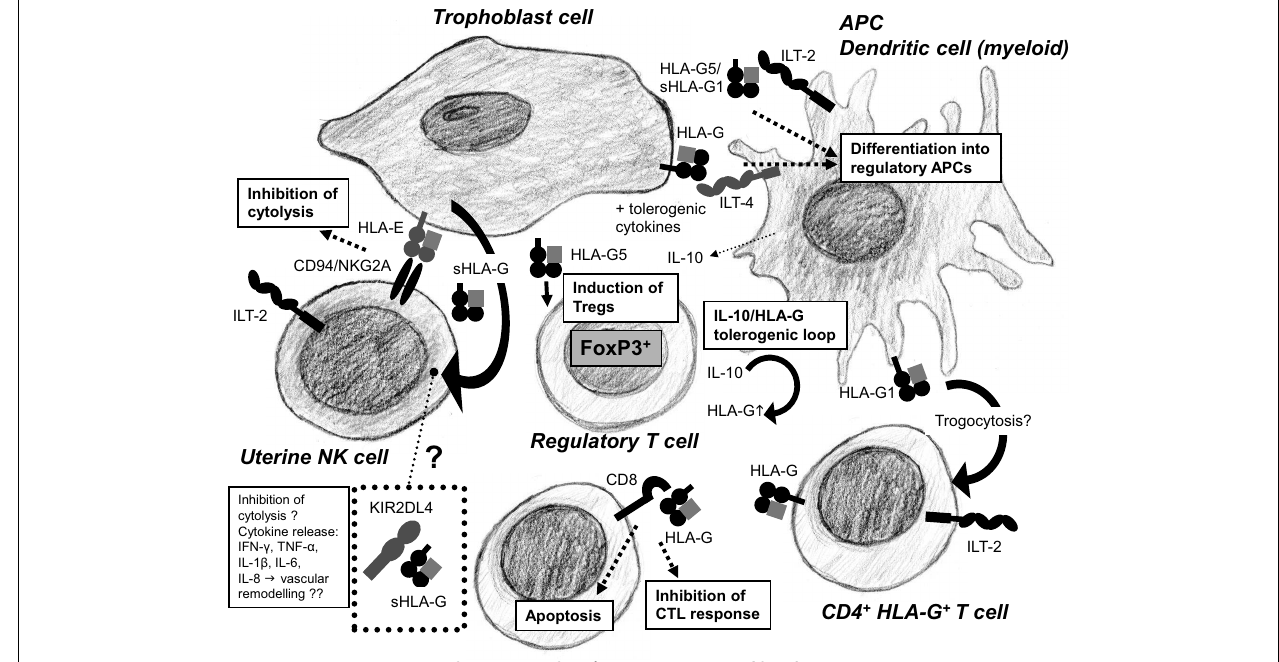
CD8 + T cells are inactivated and undergo apoptosis by binding of HLA-G to the CD8 co-receptor. HLA-E presents HLA-G derived signal peptides and bind to the CD94/NKG2A receptors on uterine NK cells inhibiting cytotoxicity. Soluble HLA-G from trophoblast cells accumulates in KIR2DL4 + endosomes in uterine NK cells, which may result in active secretion of proangiogenic and proinflammatory cytokines, although this is